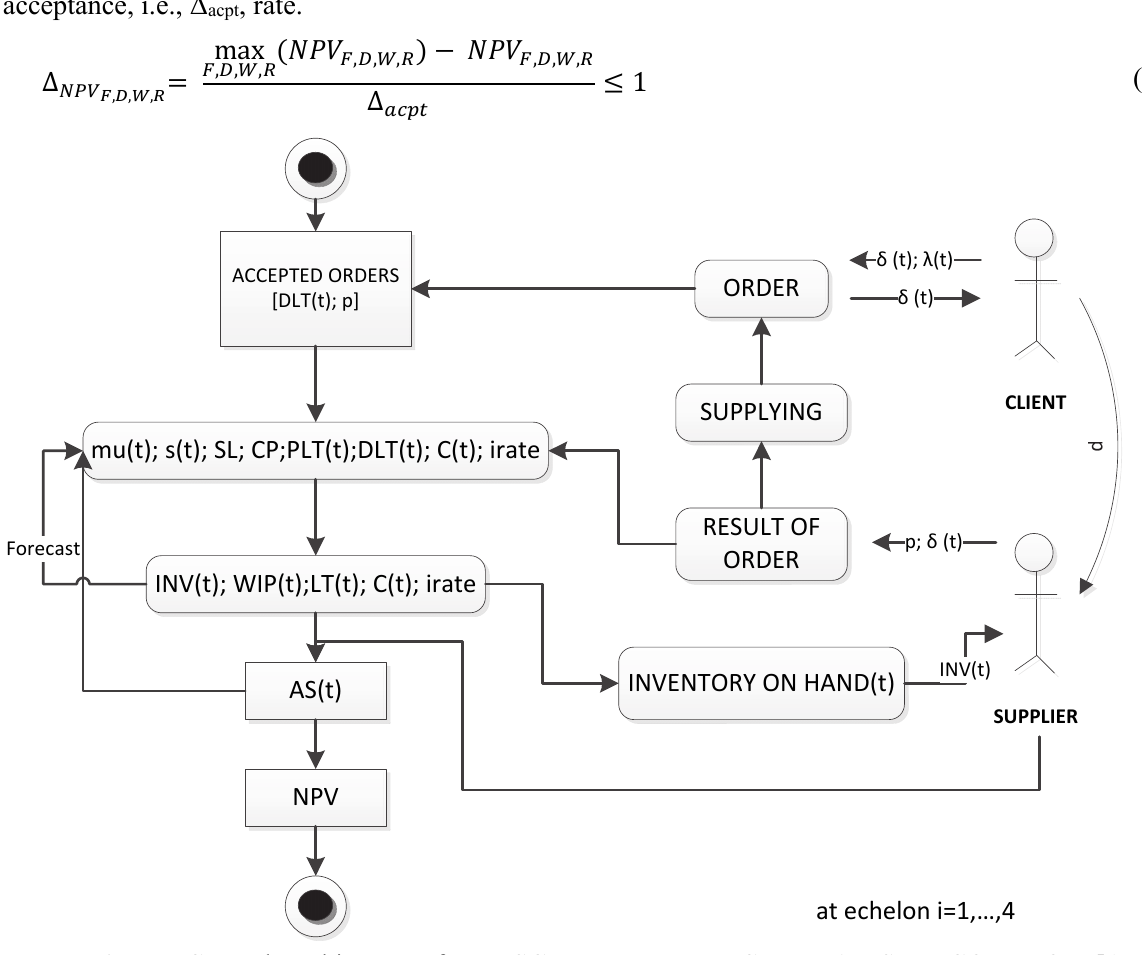
Fig. 7. Control architecture for SCs management: CENTRALISED CONTROL [ OBJ (cid:3404) (cid:4666)∑ NPV (cid:2919)(cid:2872) MAX (cid:4666)t(cid:4667) )] & DECENTRALISED CONTROL [ OBJ (cid:2930) (cid:2919)(cid:2880)(cid:2869) of strategy investment; I is the generic echelon with i=1,…,4 .